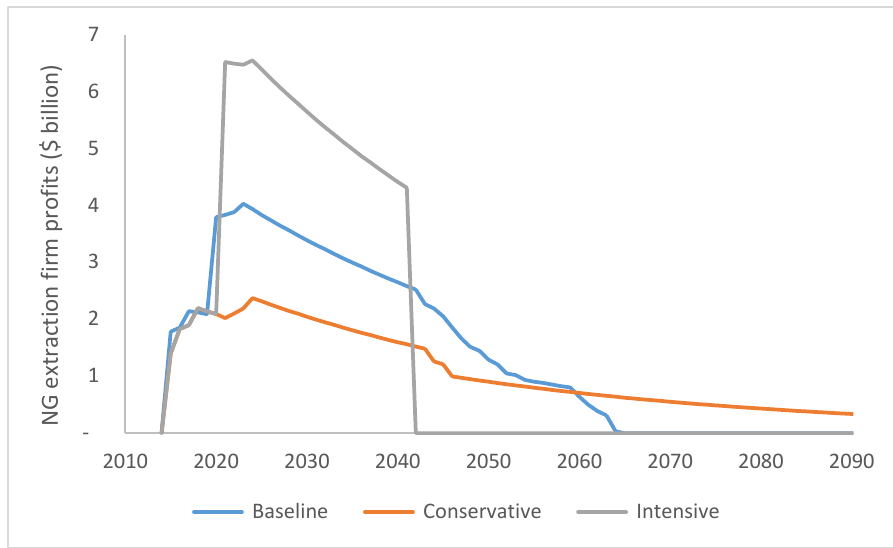
Figure 4. NG-extraction firm profits under the three scenarios.